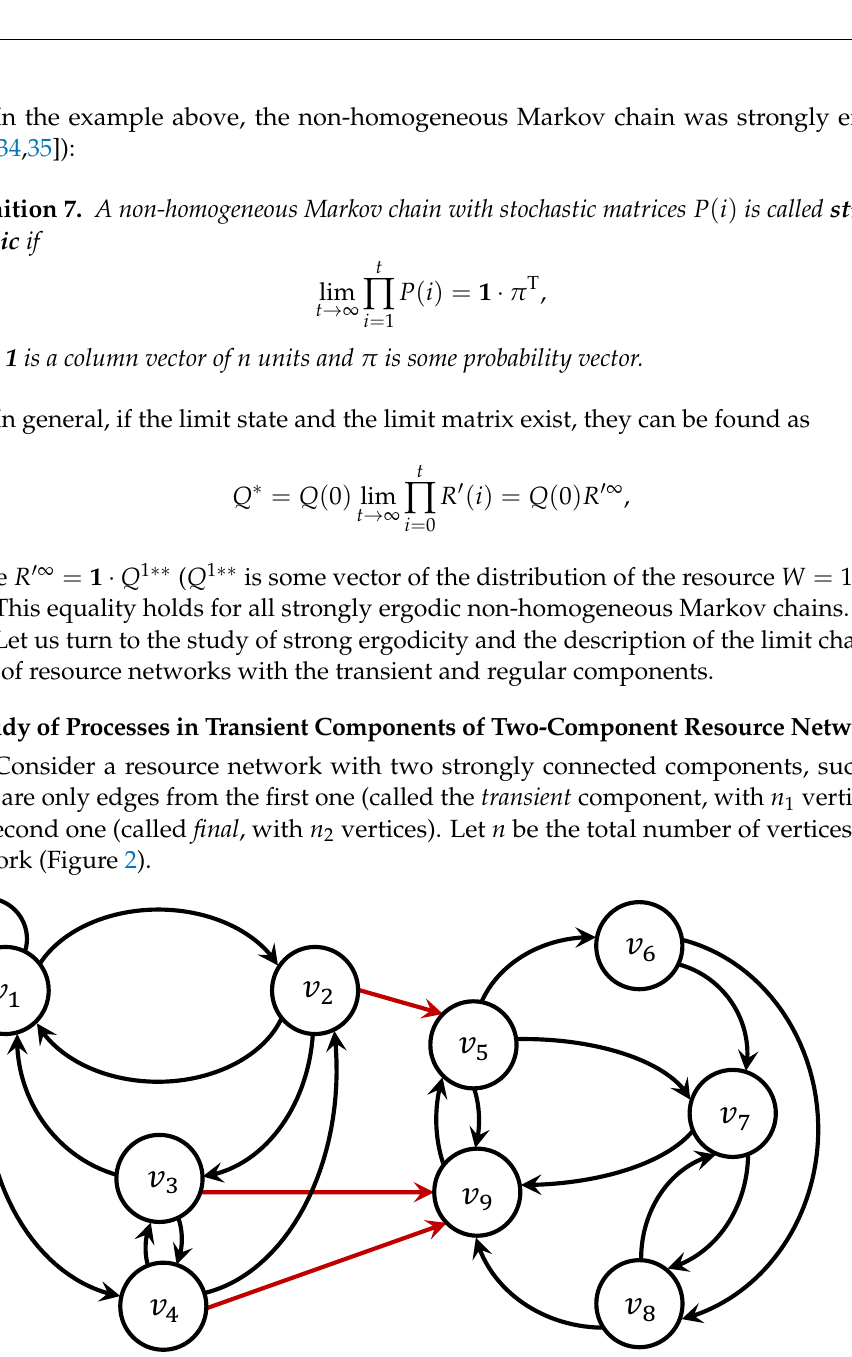
Figure 2. The two-component resource network. Vertices ( v 1 – v 4 ) belong to the transient component; vertices ( v 5 – v 9 ) form the final component; n 1 = 4, n 2 = 5, n = 9